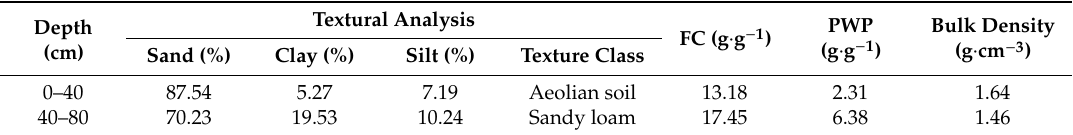
Table 2. Physical properties of the